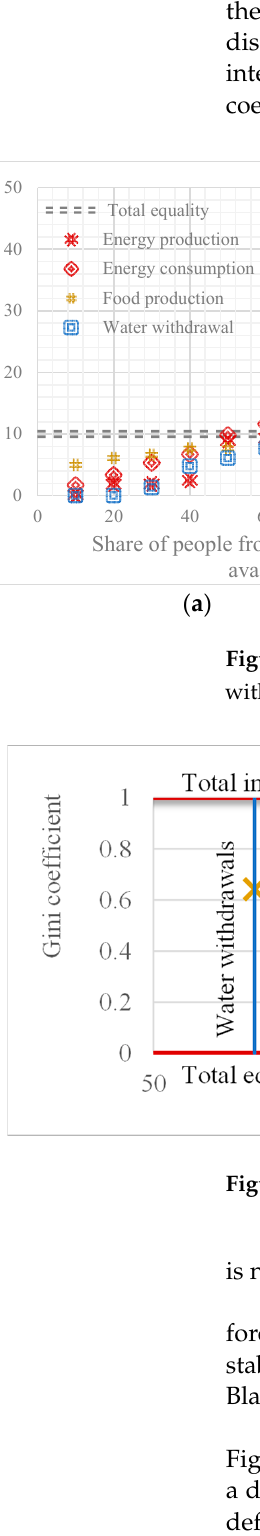
Figure 12. Balance of energy and food per capita, and GDP per capita in energy units minus the de fi cit (in absolute values) of energy and food per capita, vs. GDP per capita in energy units (2019). 6. Conclusions Land is the basic element of the foundation of the society as it is the fi eld for water, energy and food, which are the basic elements of prosperity. As the modern world is more focused on the economy than the WEF and land nexus, we studied the link of money with the nexus. For each kind of evaluation, a necessary process is to standardize all the elements in the same unit. Therefore, in this paper, we chose energy units, as they give us a